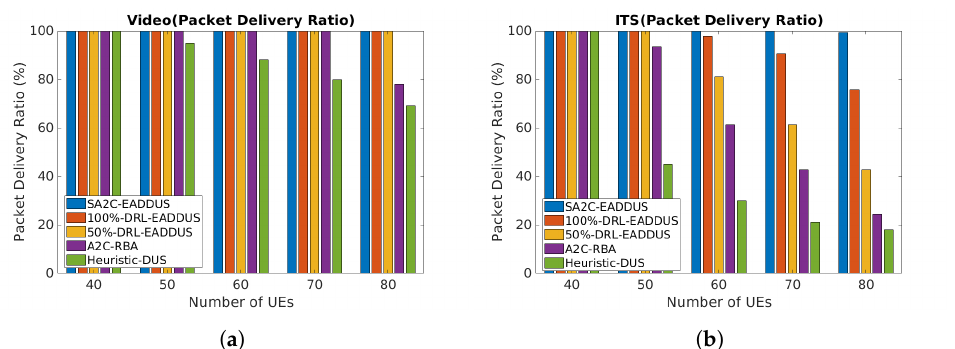
Figure 7. The overall packet delivery ratio by considering different processing capacity levels and algorithms: ( a ) the video packets’ delivery ratio; ( b ) the ITS packets’ delivery